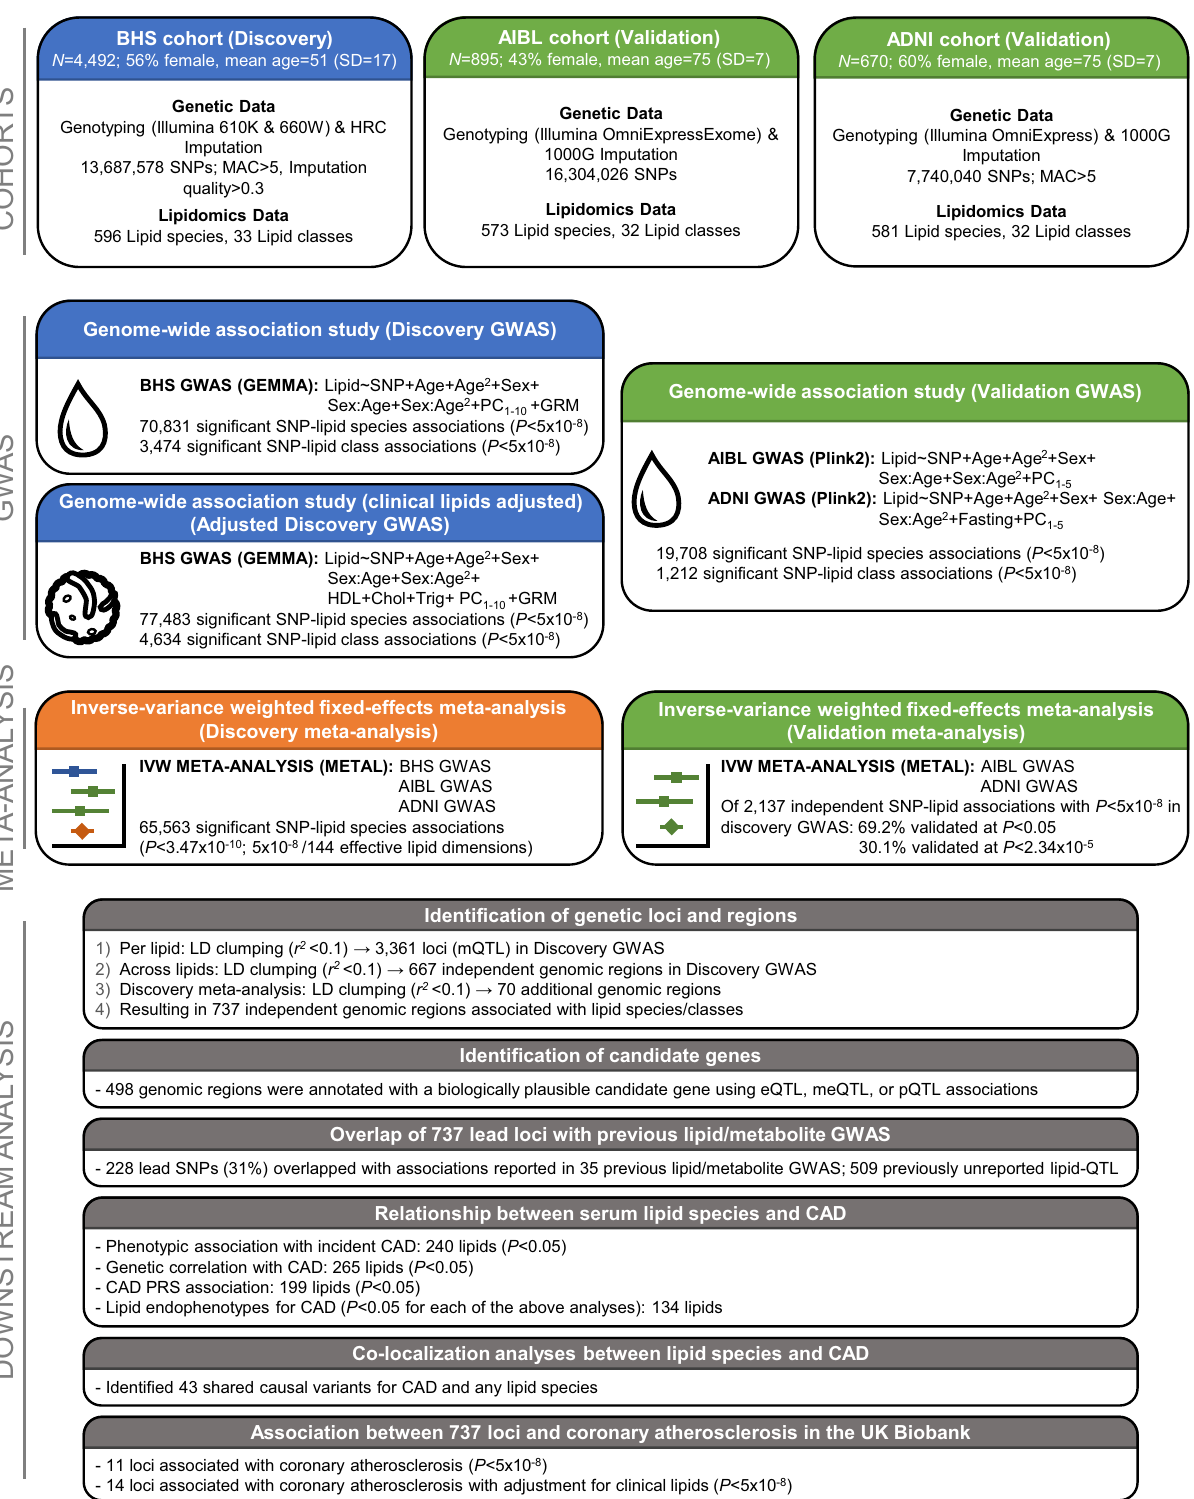
Fig. 1 Study design for the genetic analysis of the human lipidome. Representation of genome-wide association studies (GWAS) of the lipidome in the BHS discovery cohort (blue boxes), ADNI and AIBL validation cohorts (green boxes), discovery meta-analysis (orange box), and downstream analyses (grey boxes). ADNI Alzheimer ’ s Disease Neuroimaging Initiative, AIBL Australian Imaging, Biomarker & Lifestyle Flagship Study of Ageing, BHS Busselton Health Study, CAD coronary artery disease, Chol cholesterol, eQTL expression quantitative trait loci, GRM genetic relatedness matrix, GWAS genome- wide association study, IVW inverse-variance weighted, LD linkage disequilibrium, MAC minor allele count, meQTL methylation quantitative trait loci, mQTL metabolite quantitative trait loci, PC principal component, PRS polygenic risk score, pQTL protein quantitative trait loci, SD standard deviation, SNP single nucleotide polymorphism, Trig